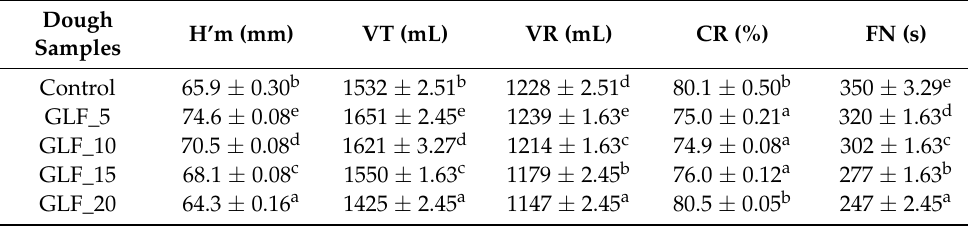
Table 3. Rheofermentometer parameters and a falling number values of dough samples with different levels of GLF